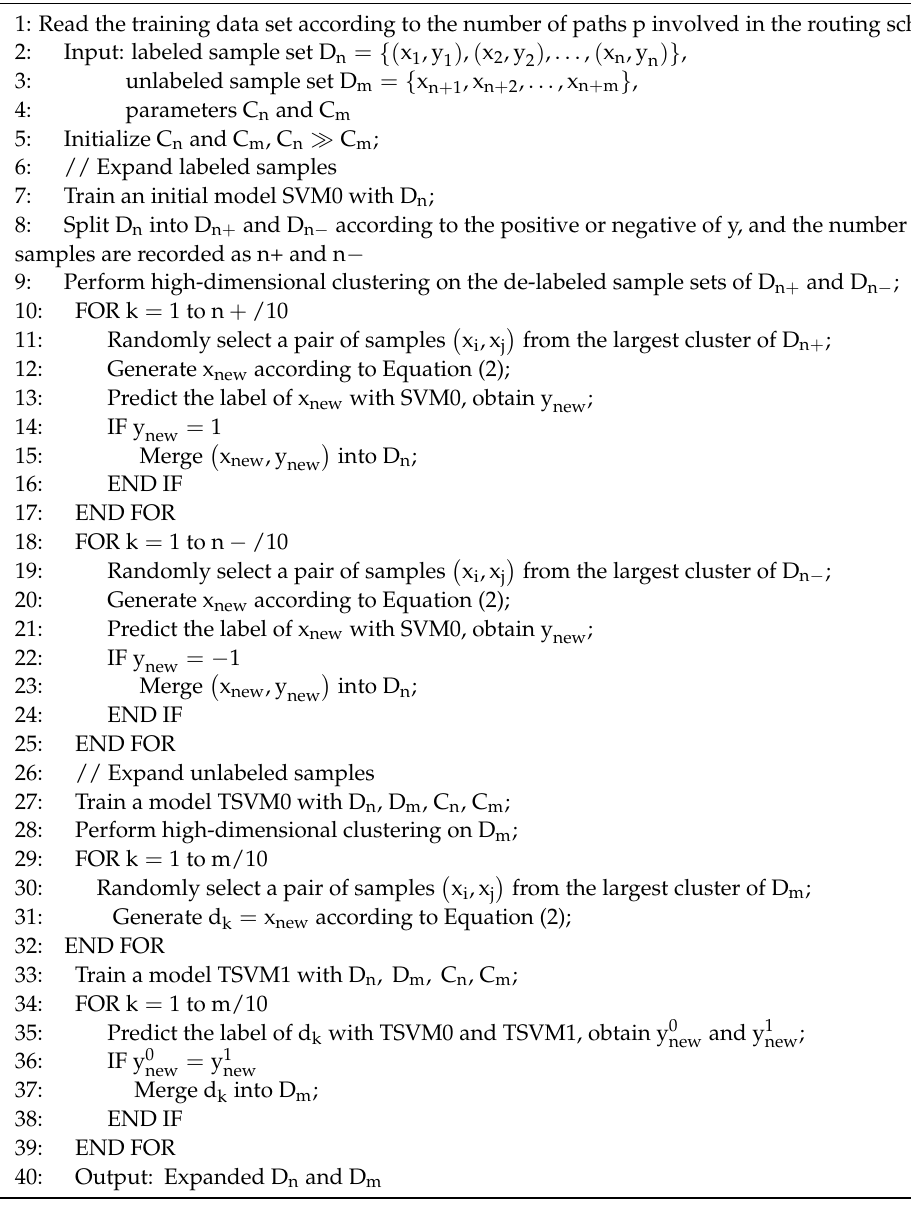
Algorithm 2: Data Enhancement for